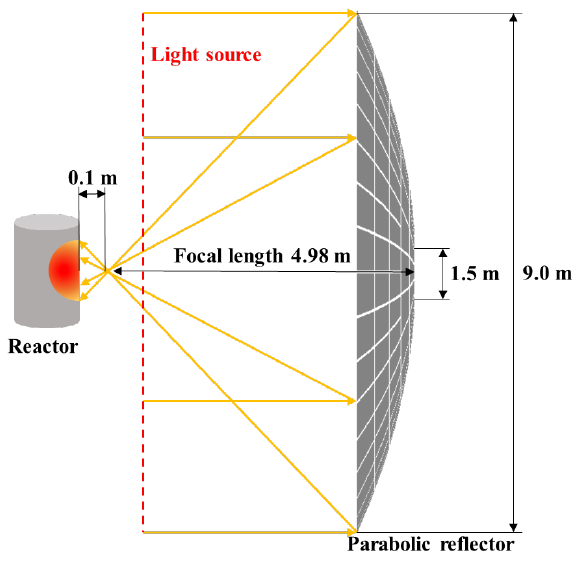
Figure 3. Parabolic